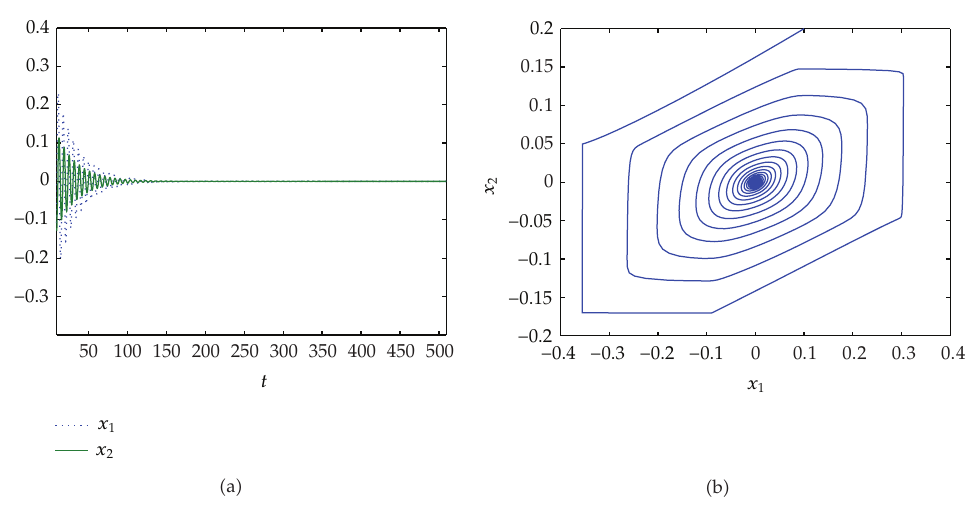
Figure 1: (cid:6) a (cid:7) Phase plot in space (cid:6) x 1 ,x 2 (cid:7) for system (cid:6) 4.1 (cid:7) with d 1 (cid:8) − 1 . 8. (cid:6) b (cid:7) Phase plot in space (cid:6) x 1 ,x 2 (cid:7) for system (cid:6) 4.1 (cid:7) with d 1 (cid:8) − 1 . 8.